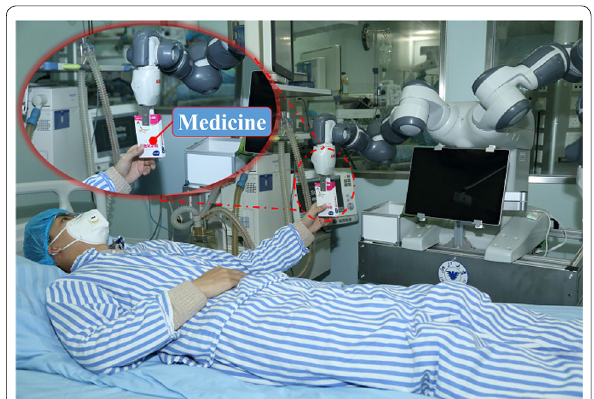
Figure 4 Remote medicine delivery using the teleoperated robot